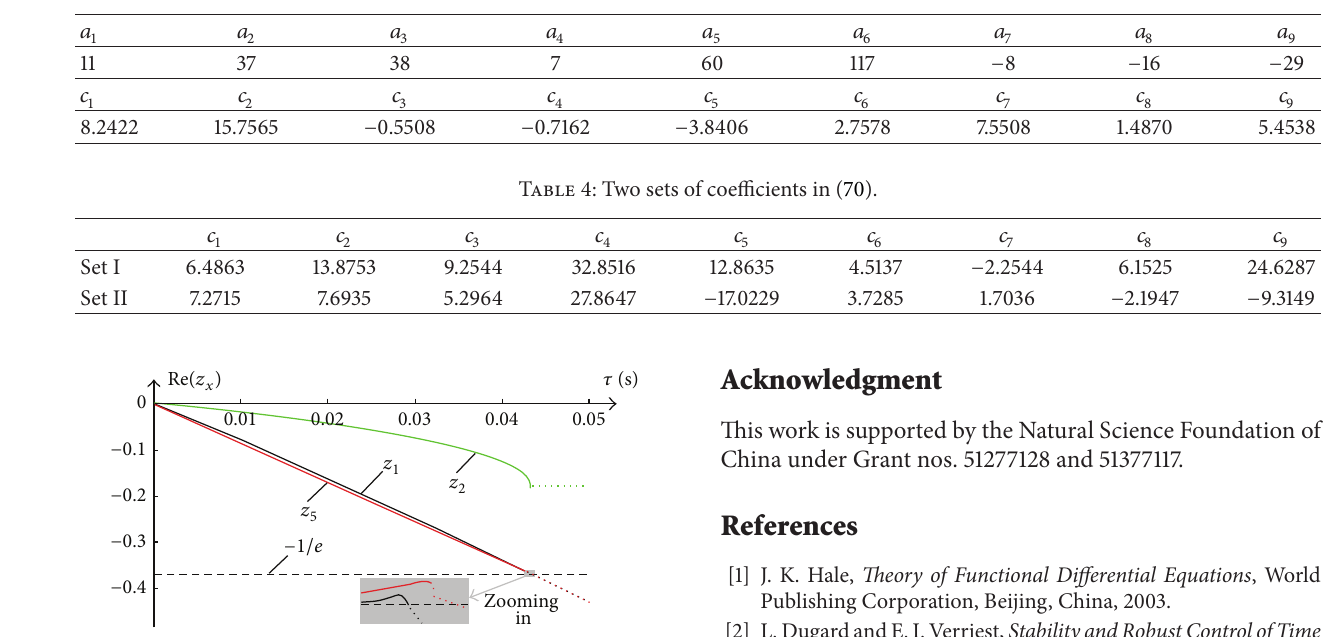
Table 3: Coefficients of CE 3 (𝑠,𝐷) given by (69) and (70).